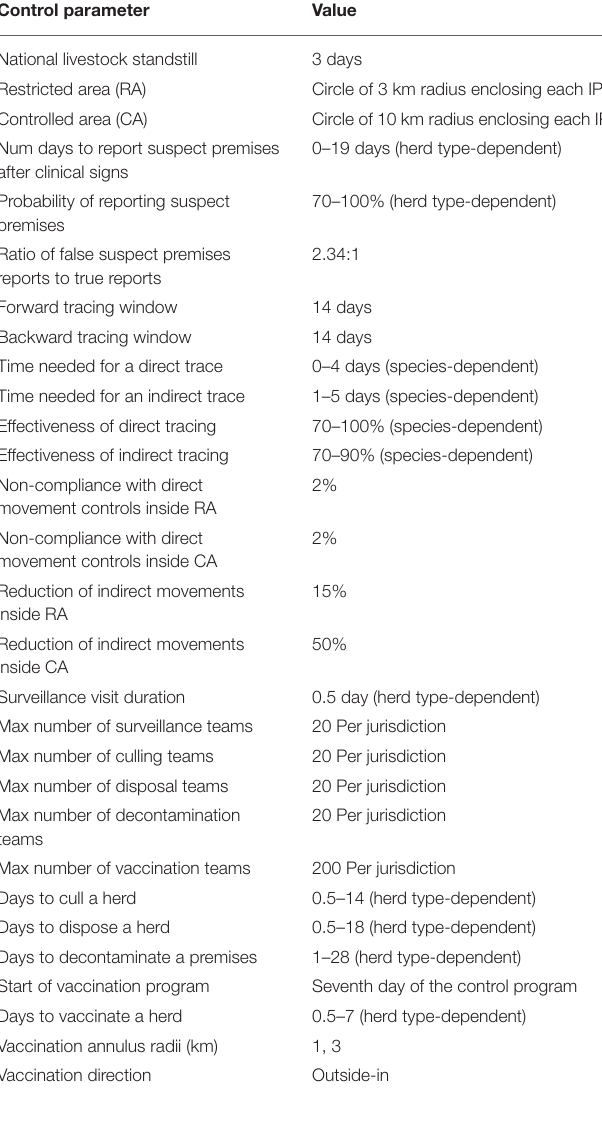
TABLE 3 | Selected control program parameter settings. Control